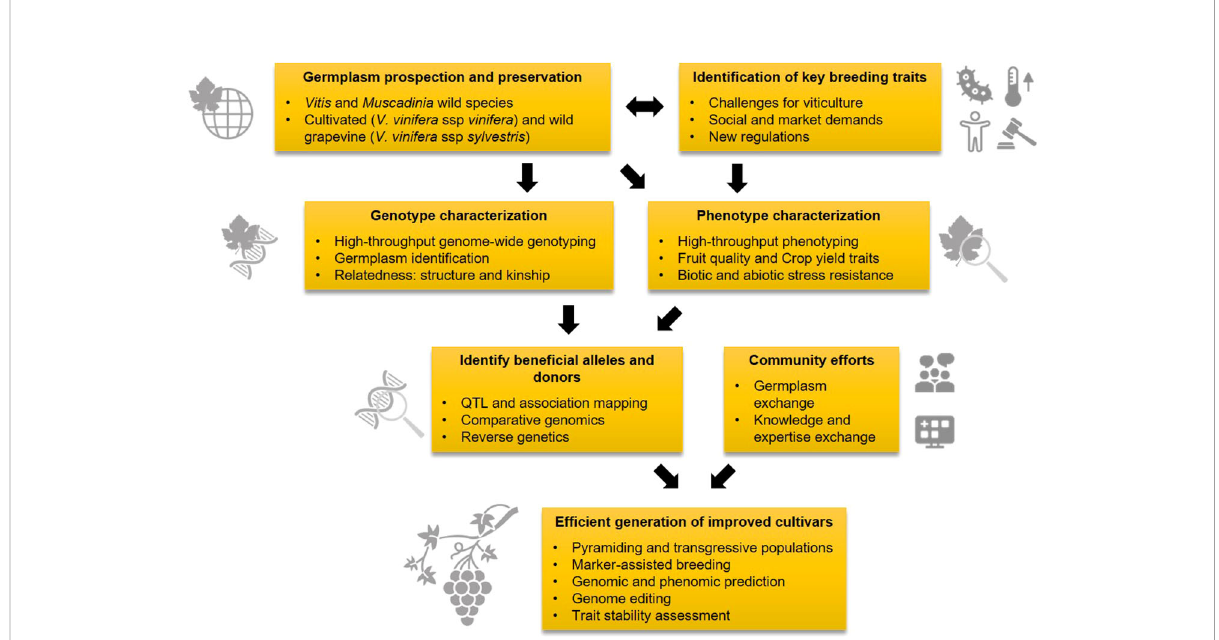
FIGURE 1 Work fl ow chart of grapevine genetic improvement activities towards high quality and sustainable grape